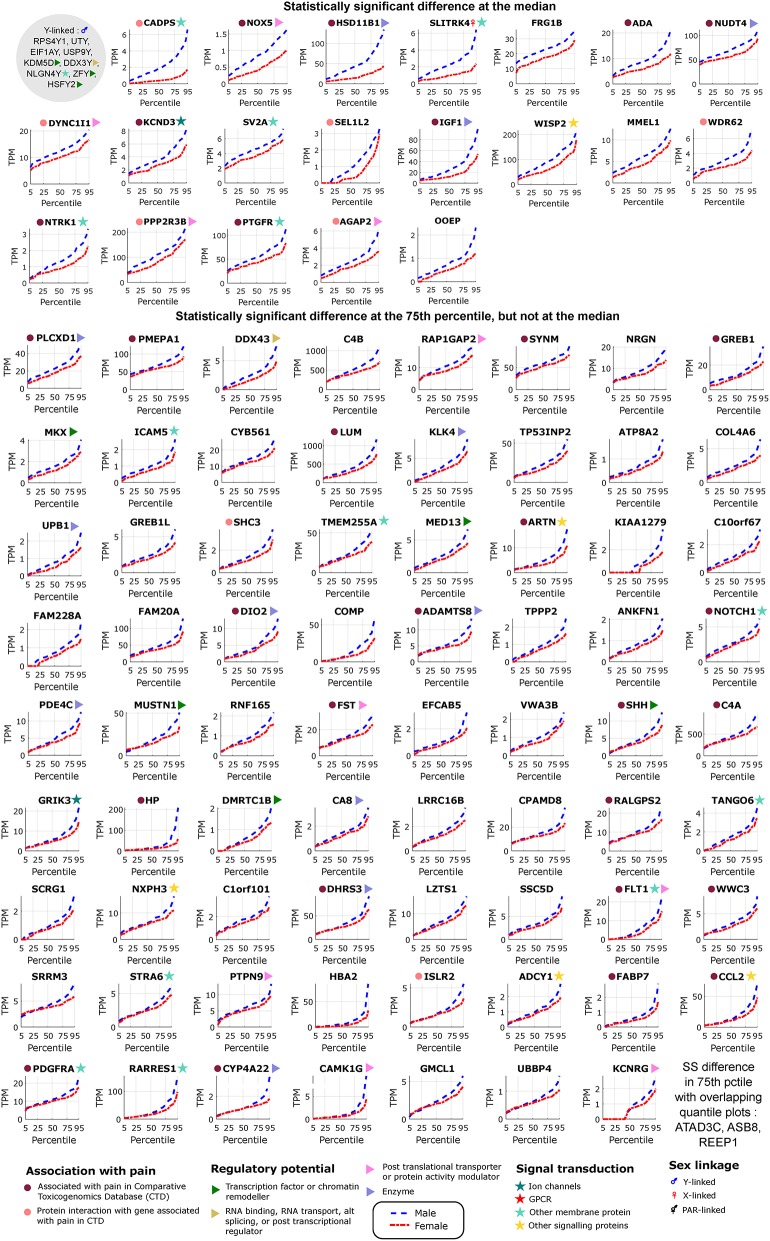
Differentially expressed genes in male tibial nerves. Quantile values for TPMs of sex-differentially expressed genes in BSL that are more abundant in males. Sex linkage, signal transduction and regulatory potential, and association with pain are also shown. Genes are shown in decreasing order of the area between the curves.